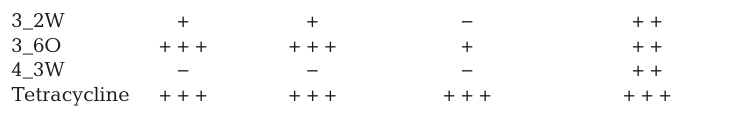
2. Antagonistic activity of surface-associated bacteria against different species of Vibrio in a well diffusion assay. Bacterial isolates—3_2W: Vibrio har- veyi ; 3_6O: Exiguobacterium acetylicum ; 4_3W: Psychrobacter sp. Antagonistic activity was assessed by the extension of an inhibition zone: no inhibition (−),